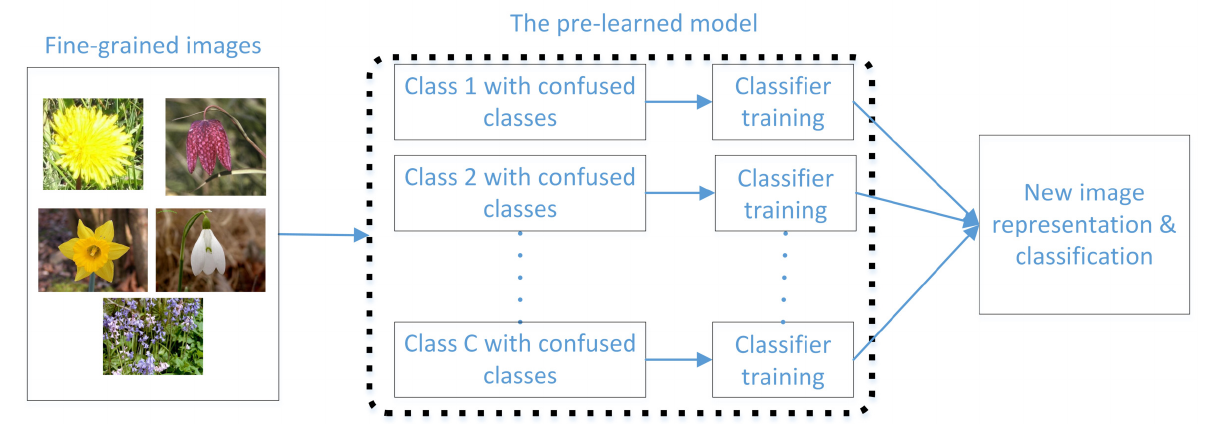
Figure 1. Flowchart of the proposed fine-grained image classification method by exploring the misclassification